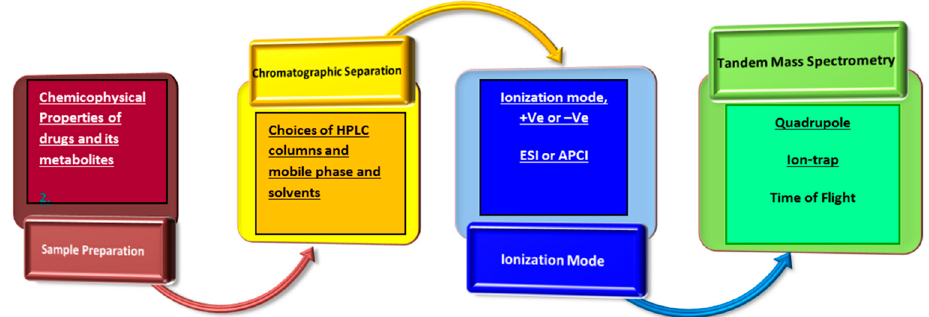
Figure 1. Pipeline for conducting bioanalysis using liquid chromatography-tandem mass spectrometry.